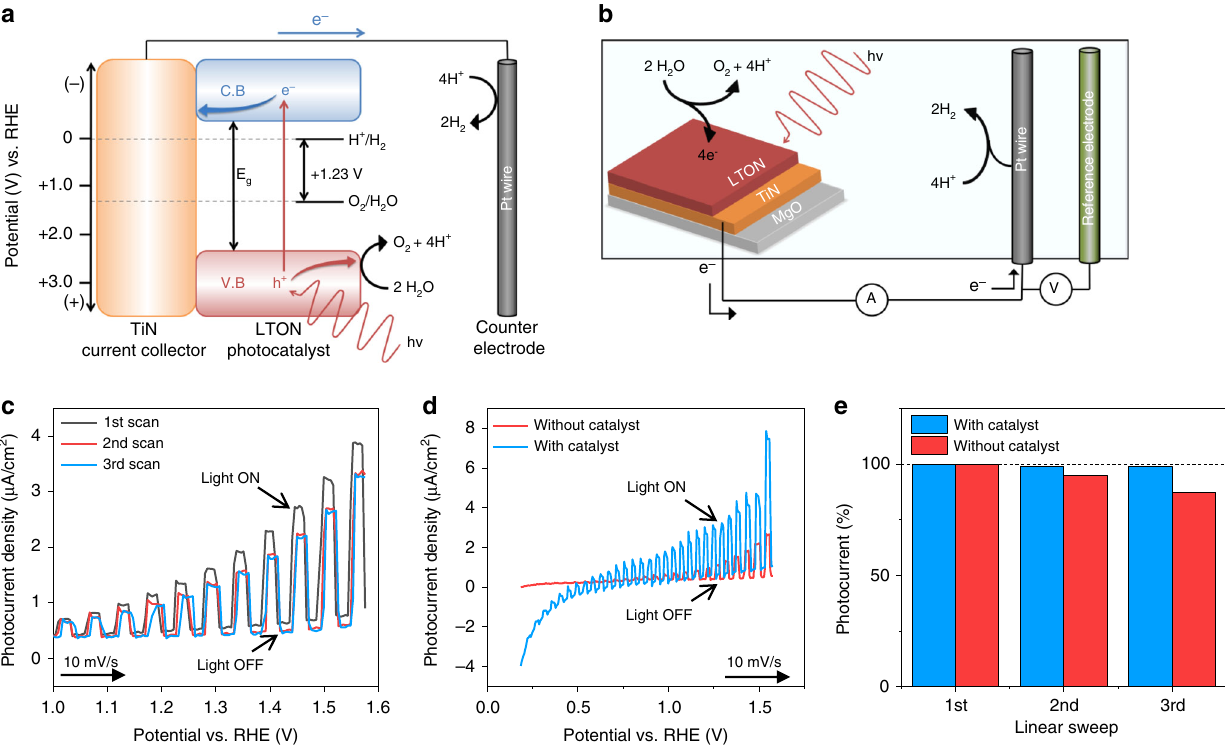
Fig. 3 Photoelectrochemical water splitting. a Energy diagram for the LTON semiconductor photocatalyst. b Photoelectrochemical three-electrode cell. c Three consecutive potentiodynamic scans for LTON without catalyst. d Stabilised photocurrent for the bare LTON fi lm and IrO 2 decorated LTON fi lm shown in red and blue respectively. e The degradation from the initial photocurrent with successive potentiodynamic linear sweeps comparing the bare and IrO 2 decorated LTON fi lms values taken at 1.5 V vs.